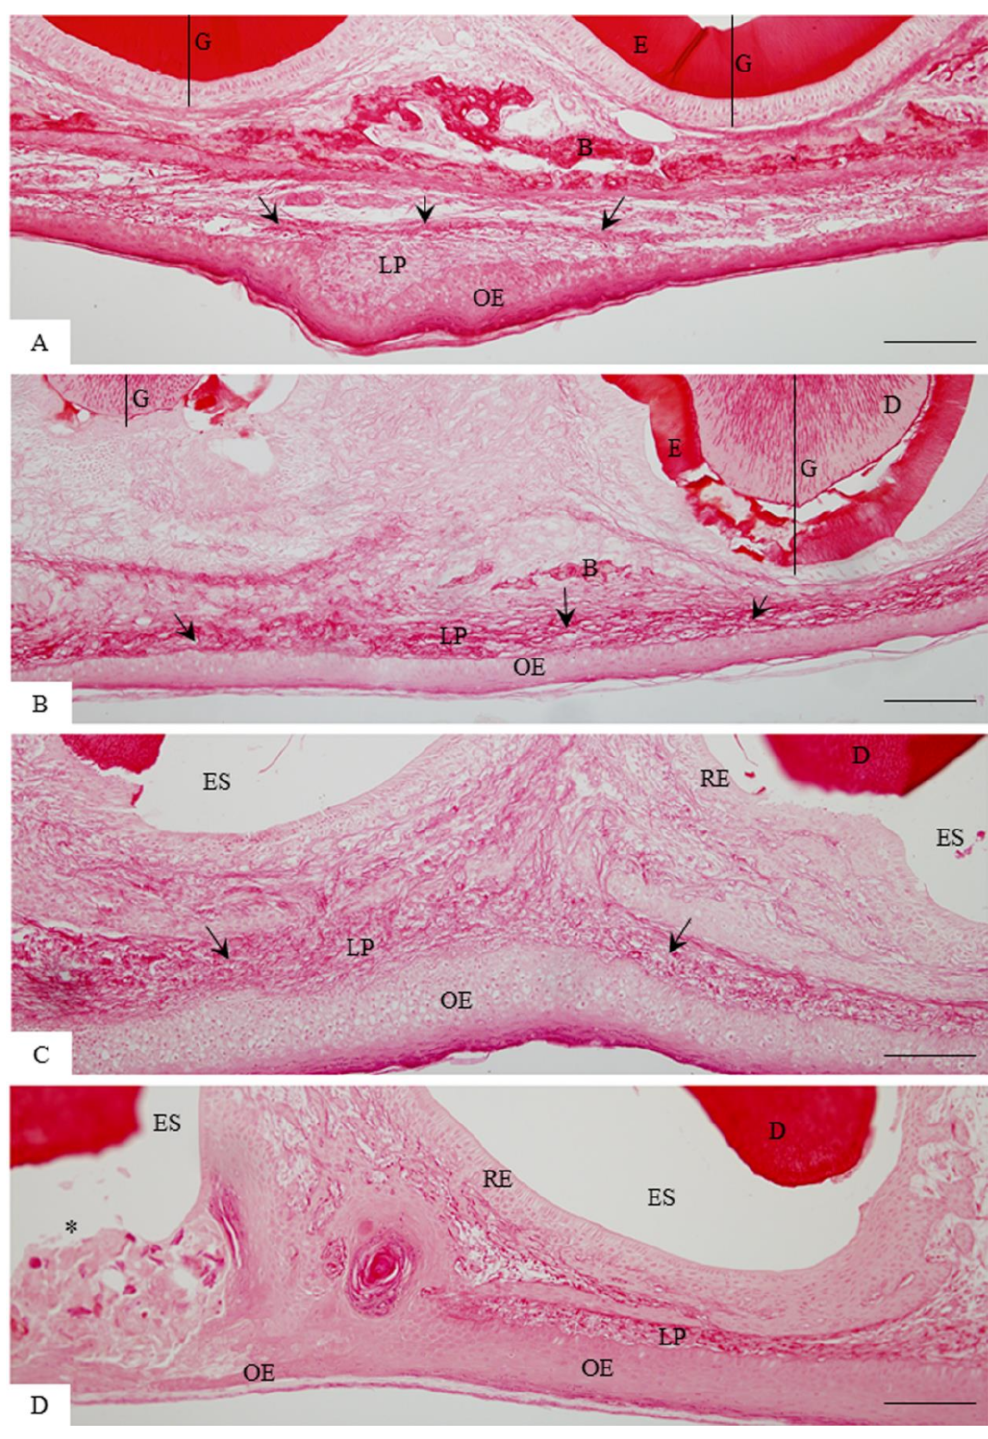
Figure 1. Light micrographs of sagittal sections of maxilla showing portions of the eruptive pathway of the first molar of 9- ( A ), 11- ( B ), 13- ( C ), and 16-day-old ( D ) rats. In A and B , the lamina propria (LP) contains bundles of collagen fibres (arrows). Note that in the 9-day-old rat ( A ), a continuous layer of bone trabeculae ( B ) is observed between the tooth germ (G) and oral epithelium (OE). In B , a thin bone trabecula ( B ) is present in the area between the molar cusps. In C and D , the delicate collagen fibres (arrows) are irregularly distributed in the thin lamina propria (LP). In D , a cusp tip (asterisk) is passing through the oral epithelium (OE). D, dentine; E, enamel matrix; ES, enamel space; RE, reduced enamel epithelium. Stained with picrosirius. Bars: 50 µ